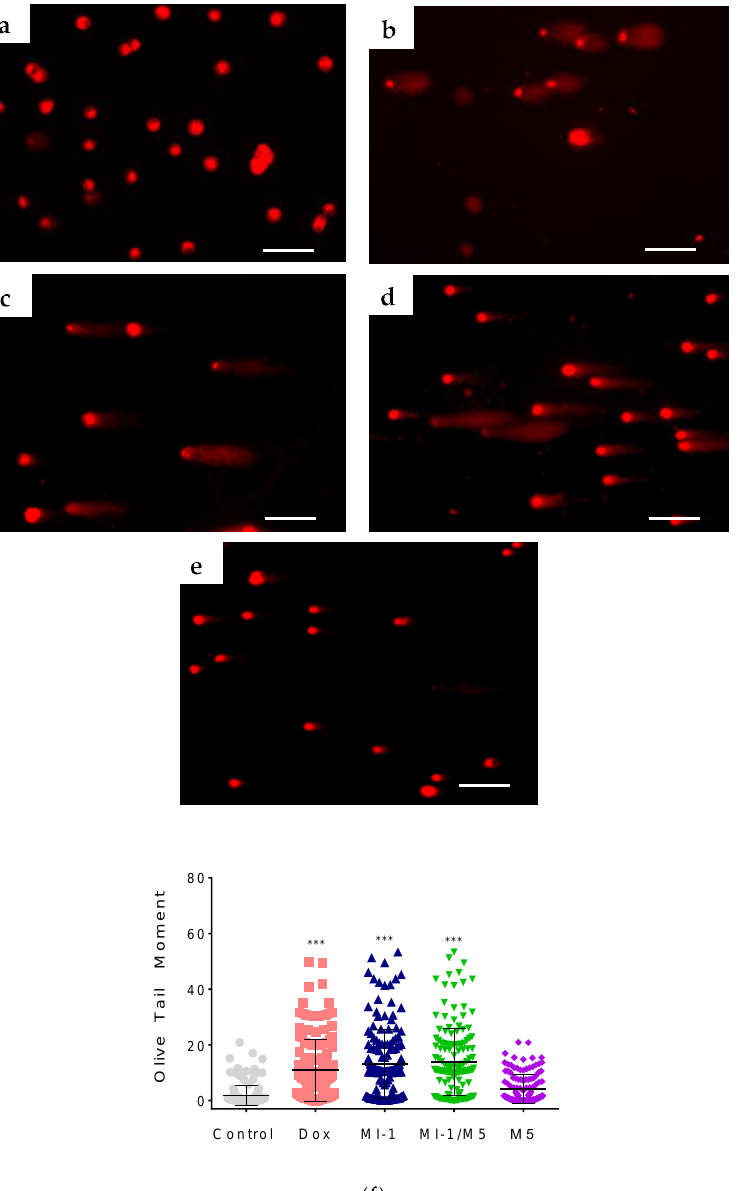
Figure 9. The DNA damage induced by studied compounds in colon carcinoma HCT116 cells (according to the results of alkaline DNA comet assay): ( a ) control; ( b ) doxorubicin (Dox, 0.9 µg/mL); ( c ) MI-1 (0.9 µg/mL); ( d ) complex MI-1/M5 (0.9 µg/mL); ( e ) polymer M5 (0.9 µg/mL); ( f ) quantitative data of DNA damage (Olive Tail Moment) in treated HCT116 cells. *** p < 0.001 (significant changes compared with control (non-treated) cells). Scale 50 µm. The DNA targeting effects were reported for maleimide derivatives RG108 and RG119- 1 (1-[2-(1H-Indol-3-yl)-ethyl]-pyrrole-2,5-dione) that possess the DNA methyltransferase inhibition activity